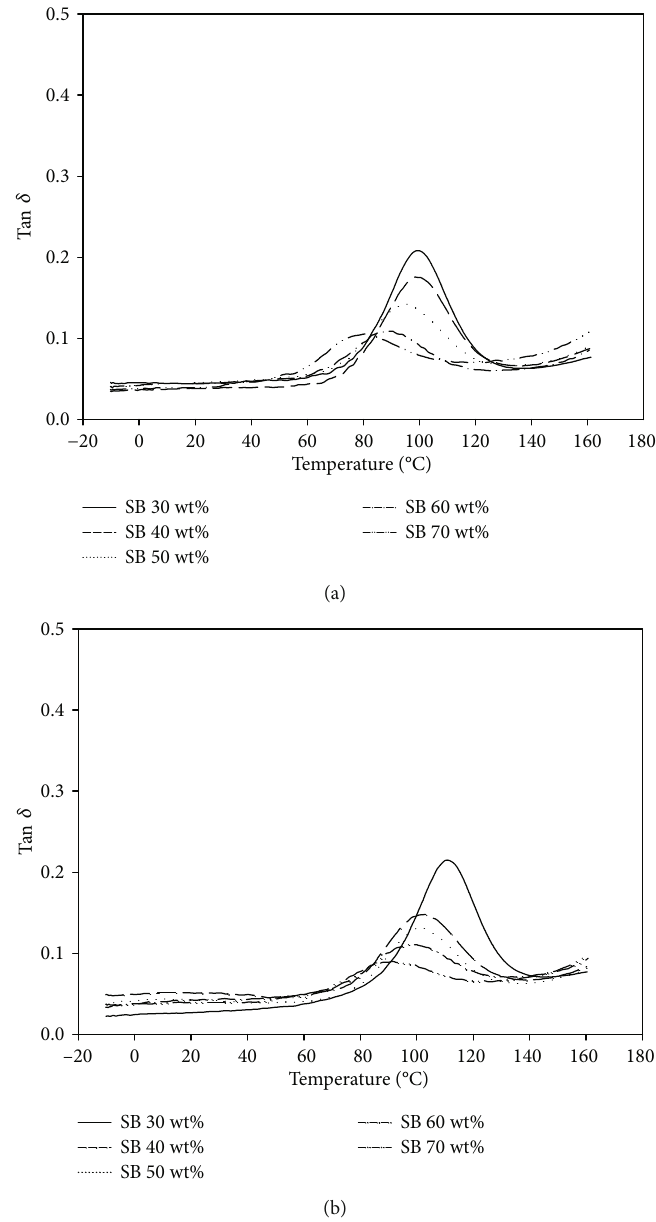
Figure 5: Tan δ of PU-EP graft-IPNs added modi fi ed sugarcane bagasse. (a) PPG 700 PU-EP; (b) PPG 1000